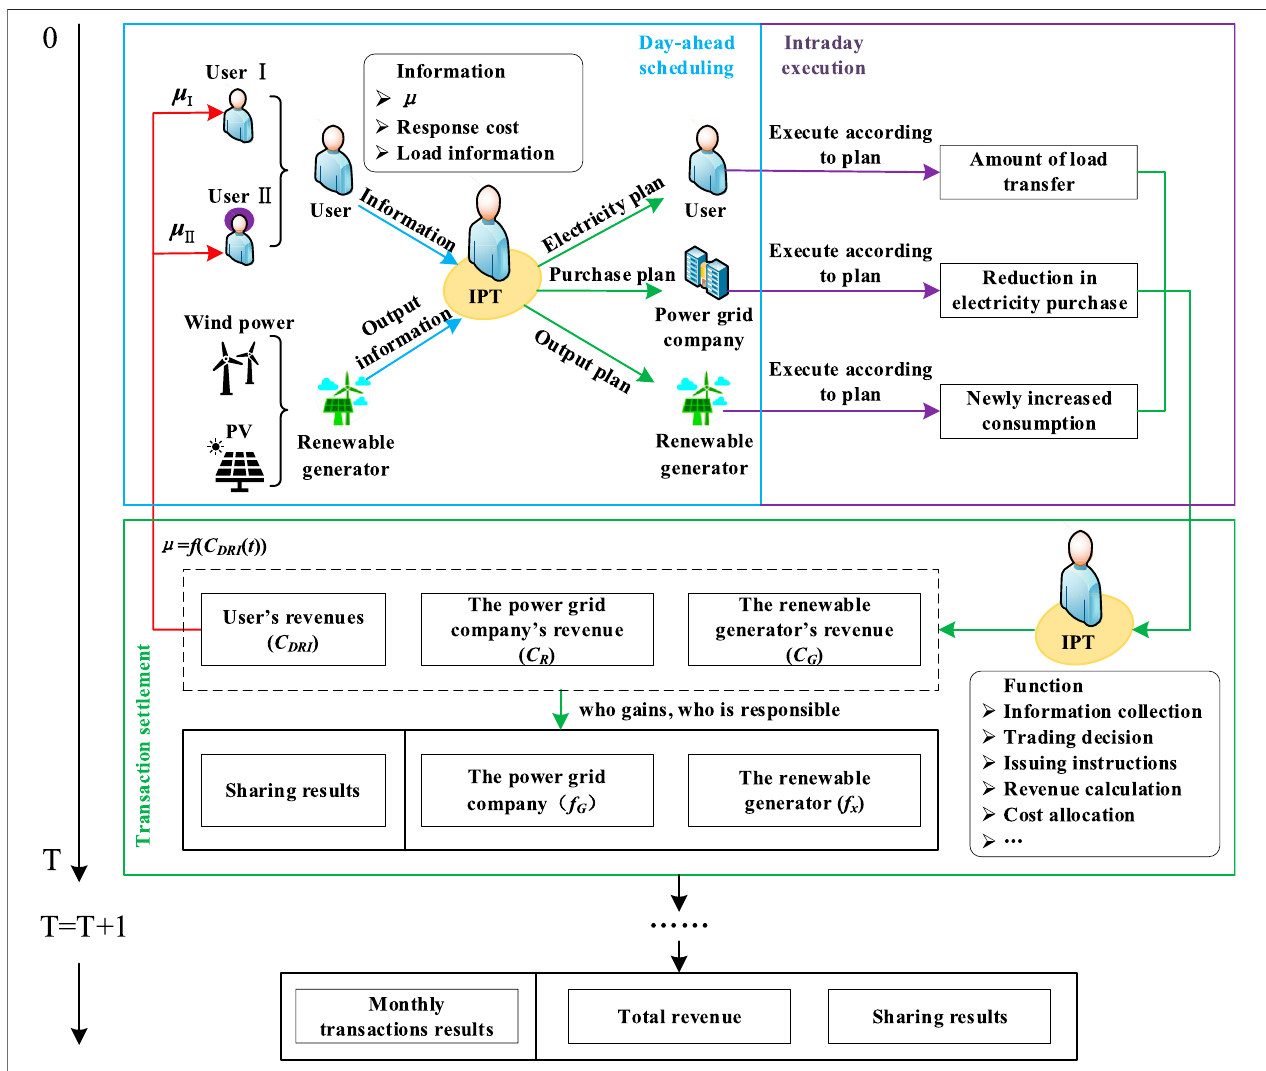
FIGURE 1 | Transaction mechanism